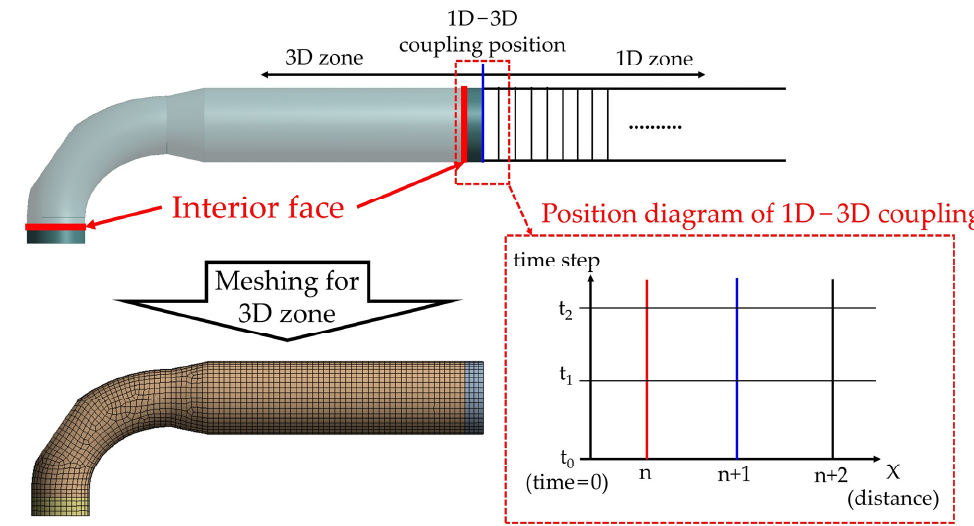
Figure 2. The interior face, mesh modeling and position diagrams used in the 1D–3D coupling al- gorithm.